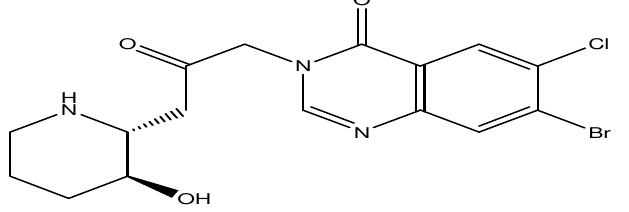
Figure 1. Structure of 7-bromo-6-chloro-3-[3-[(2 R , 3 S )-3-hydroxy-2-piperidyl]-2-oxopropyl] -